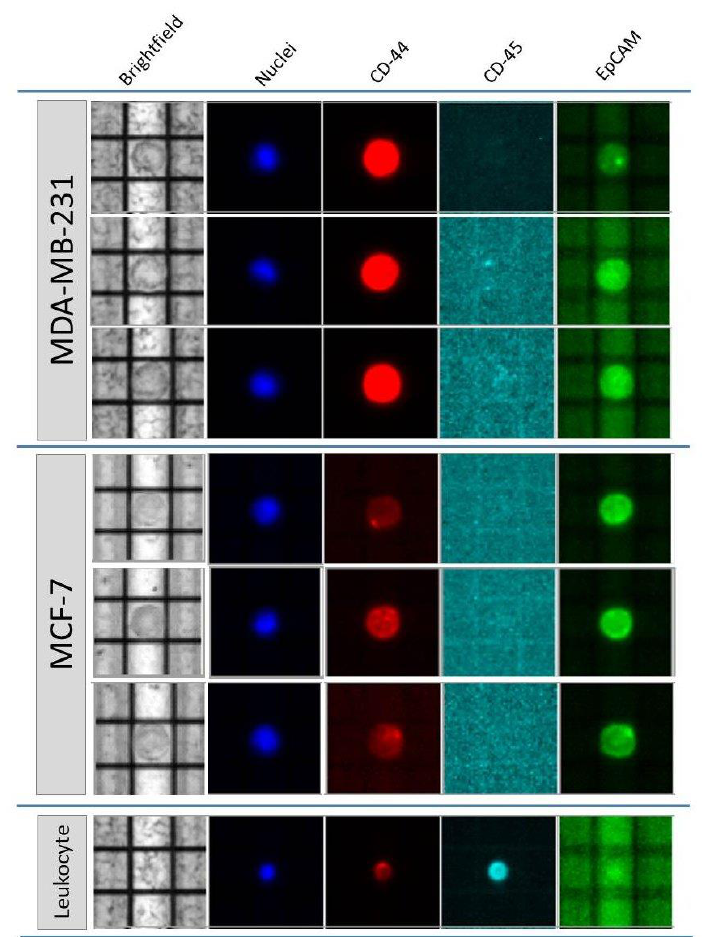
Figure 1. Analysis of MDA / MCF-7 and leukocyte cells on DEPArray TM . The panel shows the morphological and fluorescent characteristics of MDA-MB-231 (MDA) or MCF7 cells spiked into healthy donor blood and isolated on DEPArray TM . MDA cell is typically CD45-negative and Hoechst-positive (light blue and blue stains). In the first lane, a low EpCAM-positive MDA cell can be observed. MCF7 cells are all EpCAM-positive and show di ff erent expressions of CD44, almost negative (lines 4 and 6), and occasionally positive (line 5). In comparison, below, a CD44-positive / CD45-positive and Hoechst-positive leukocyte is shown.